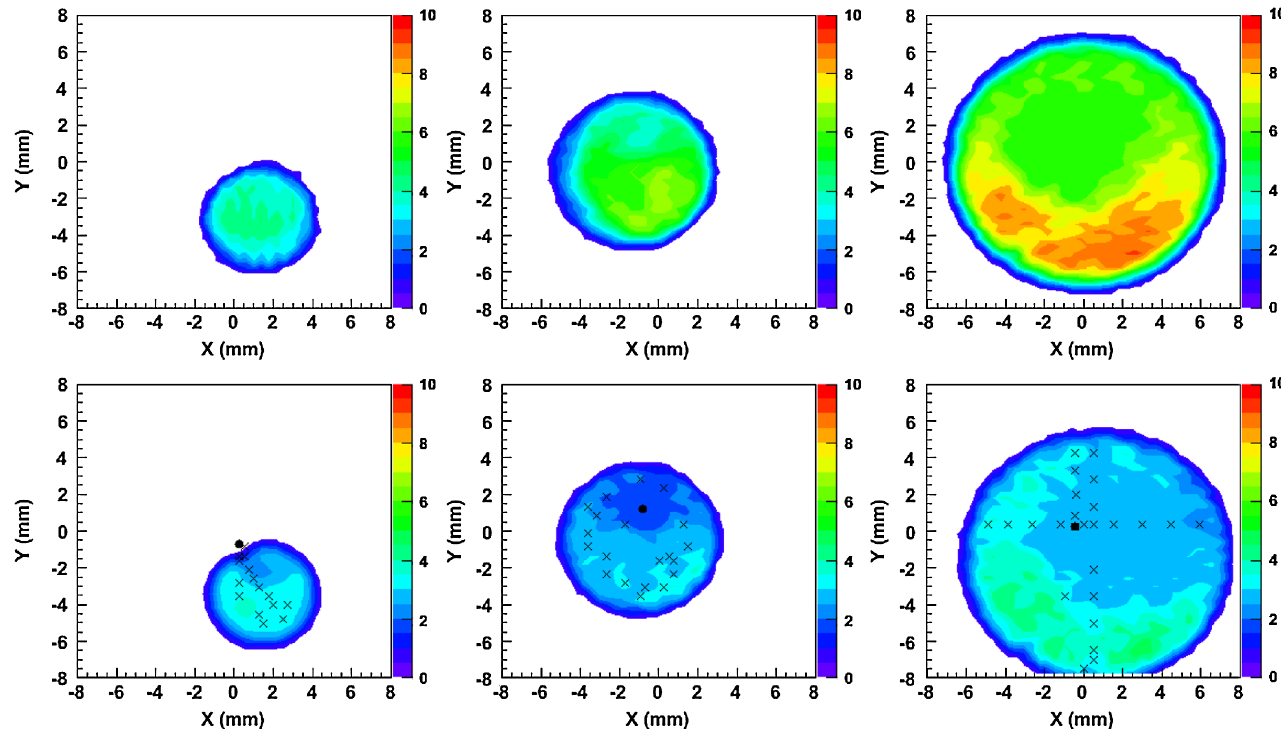
FIG. 7. False color images of photocathode QE after activation (upper) and after completing the lifetime measurements (lower) for the 5, 7, and 12.8 mm diameter activations, respectively. The crosses indicate location of each lifetime measurement and the filled circle is the estimated